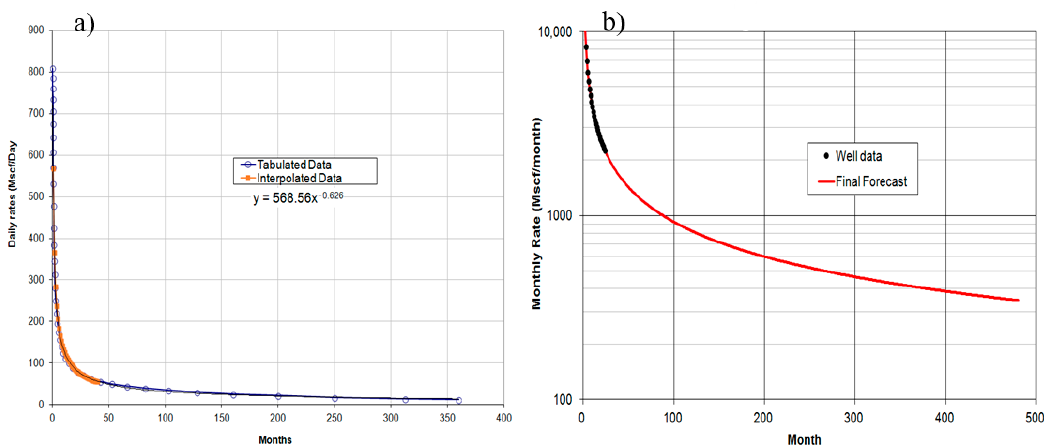
Figure 8. Computing DCA parameters. ( a ) Step 1 interpolates 40 months of historic production data from the ResFrac simulator daily rate type curve for Well 2H. ( b ) Step 2 uses the noise-free 40 months of production data to history match the monthly rates with a DCA least squares regression solver-fit. The regression returns a b -value of 1.596.